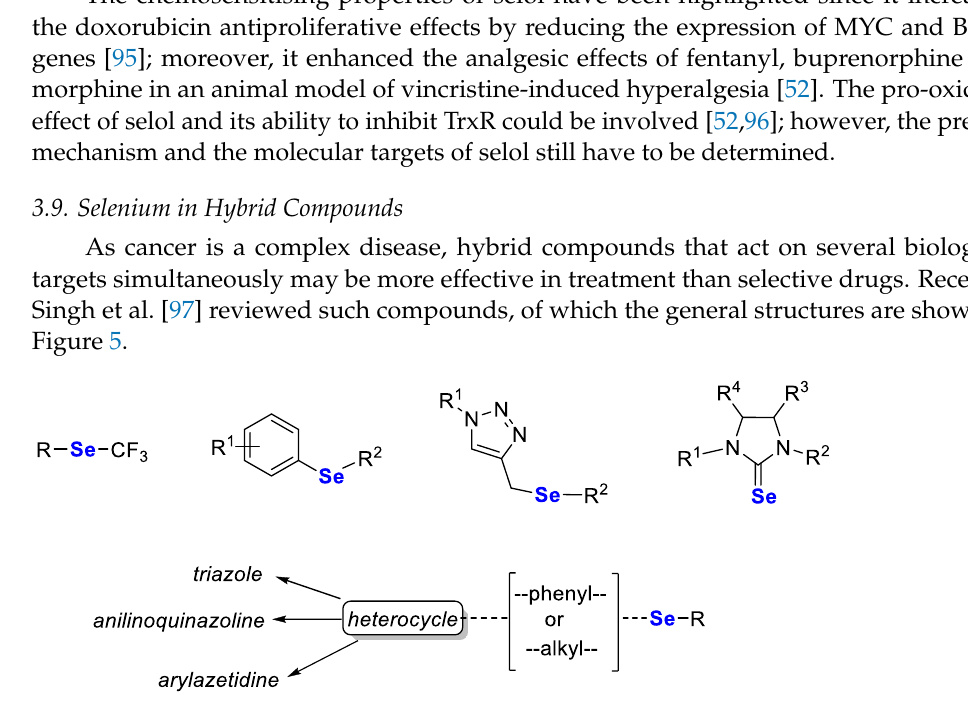
Figure 5. General structures of selenium – based hybrids described in the review of Singh et al. [97].